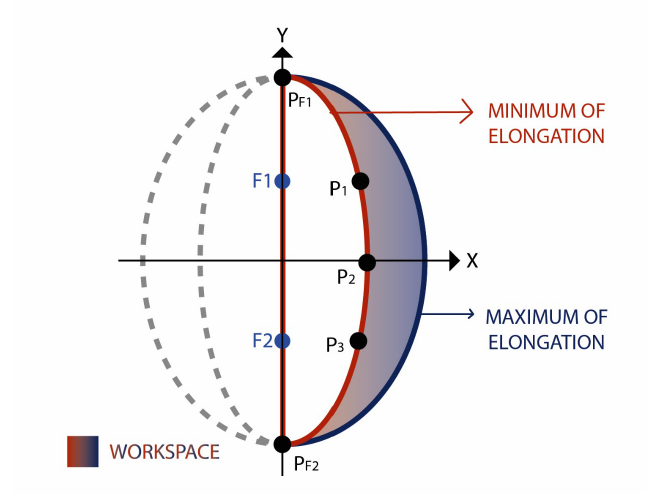
Figure 8. Geometrical incision behavior; the model has a symmetrical